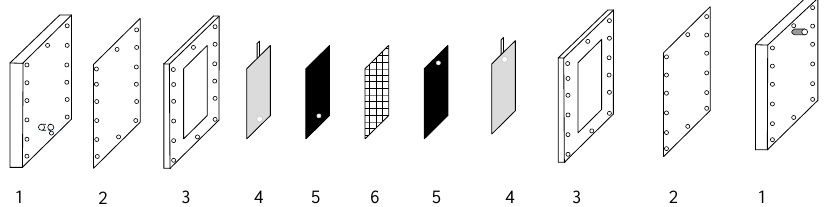
Figure 6. Schematic diagram of the inner structure of the capacitive deionization (CDI) module.